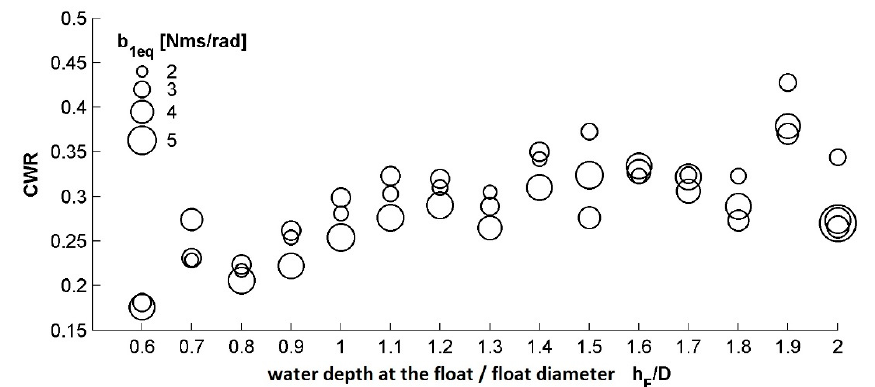
Figure 8. CWR of the float-only system as a function of float damping b 1eq , water depth at the float h F /D . Wave C.